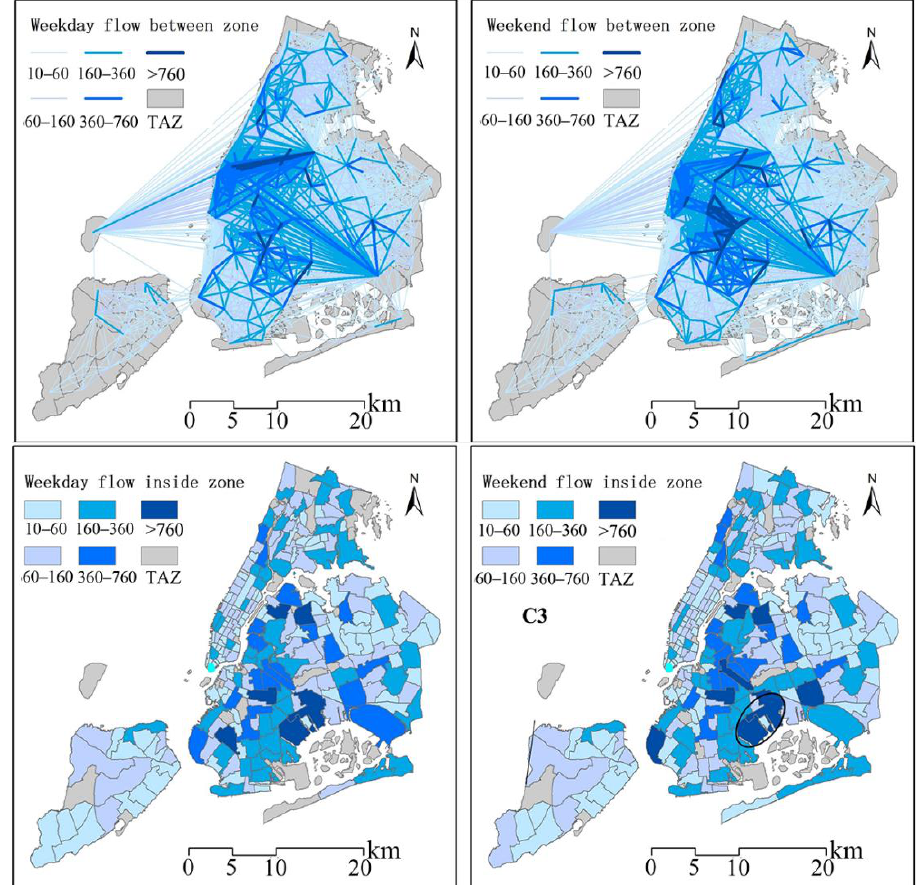
Figure A6. Trip flow diagram between and inside TAZs in New York.